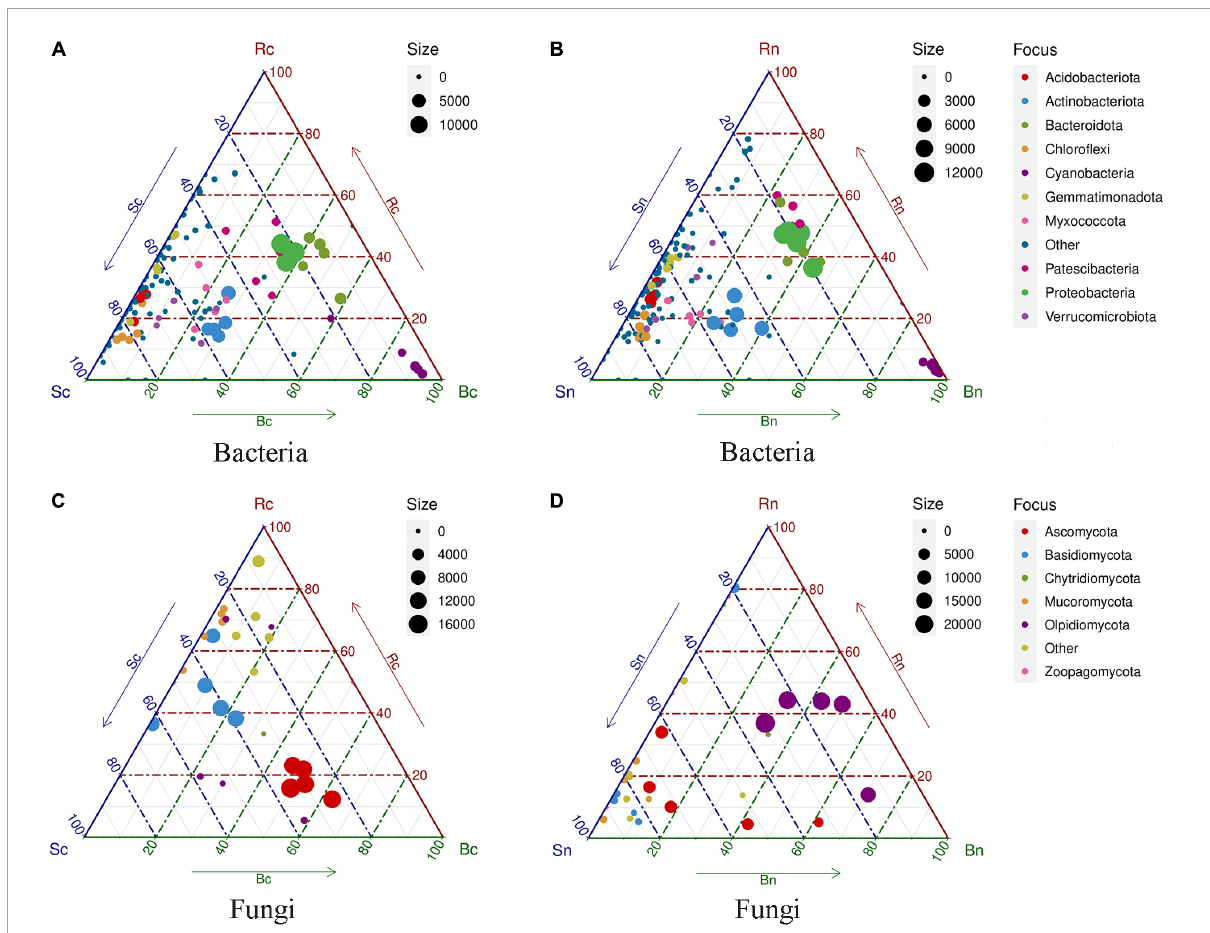
FIGURE4 Ternary plots indicating compartment specificity of phyla from bacterial and fungal communities. Each color circle represents a phylum level. The dimension of each circle represents its weighted average. The position of each circle is decided by the contribution to the three compartments (bulk, rhizosphere, and beetroot) to the total weighted average. The dotted latticework of each triangle indicates 20% increments of contribution. Panels (A,B) representing ternary plots of the bacterial community of two treatment groups; (C,D) representing ternary plots of the fungal community of two treatment groups. Sc, continuous cropping bulk soil; Sn, non-continuous cropping bulk soil; Rc, continuous cropping rhizosphere soil; Rn, non-continuous cropping rhizosphere soil; Bc, continuous cropping sugar beetroot; Bn, non-continuous cropping sugar